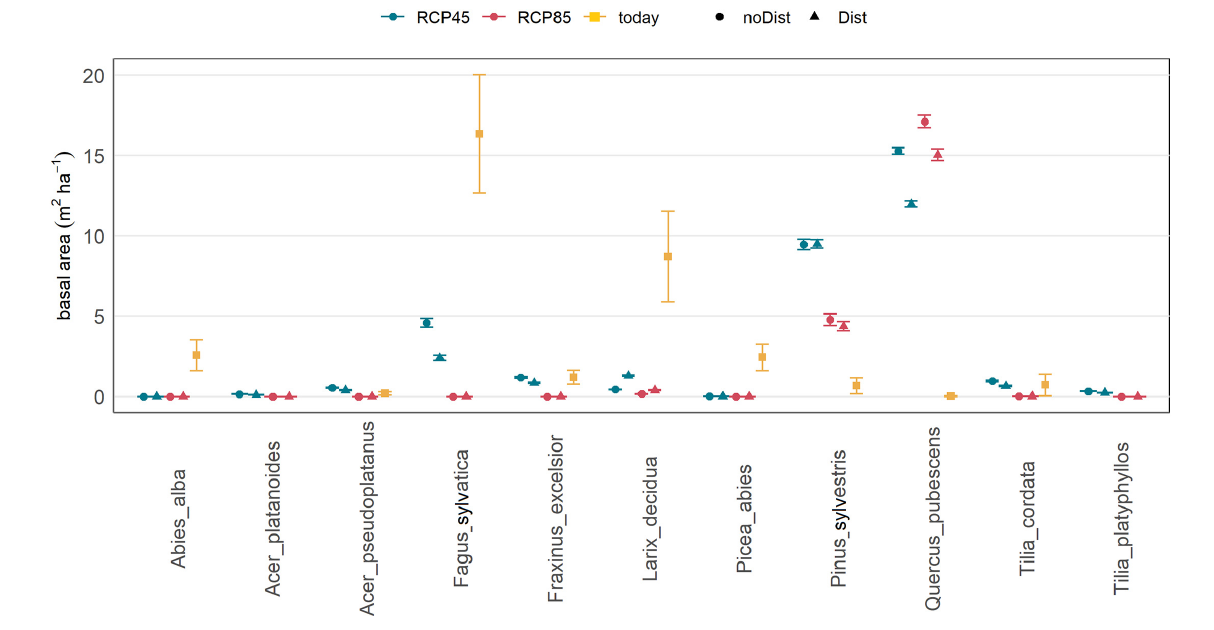
FIGURE 6 | Basal area per main species after 150 years of simulation with climate scenario RCP4.5 ( above ) and RCP8.5 ( below ) and for low (blue) and high (red) background disturbance (Dist) as well as the basal area of the current forest